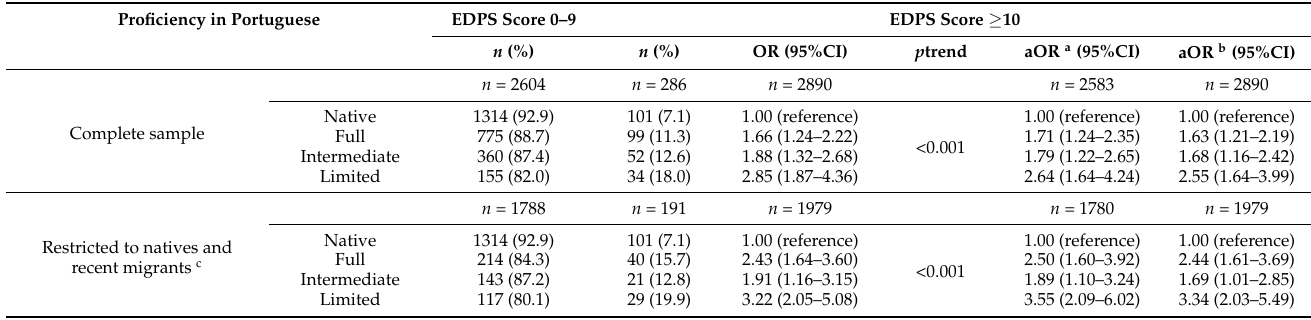
Table 2. Associations between language proficiency and EPDS scores ≥